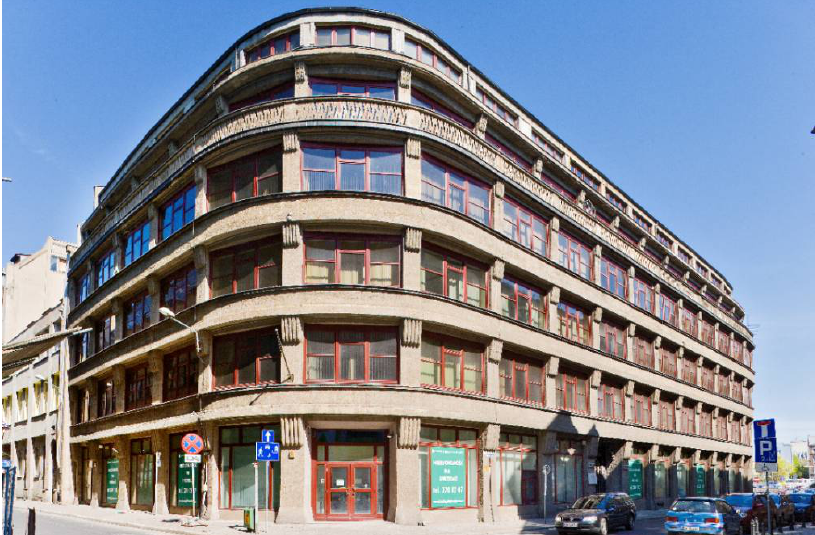
Figure 4. Office building in Junkernstrasse (today’s Ofiar Oswięcimskich Street), built in 1911–1912 and designed by Hans Poelzig, contemporary view (photo S. Klimek).